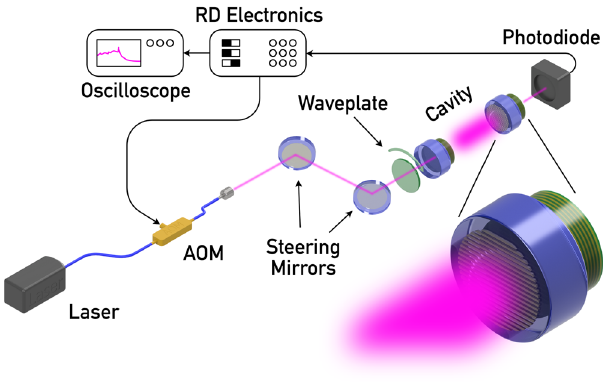
Fig. 5 Cavity ring-down setup for the measurement of cavity fi nesse.